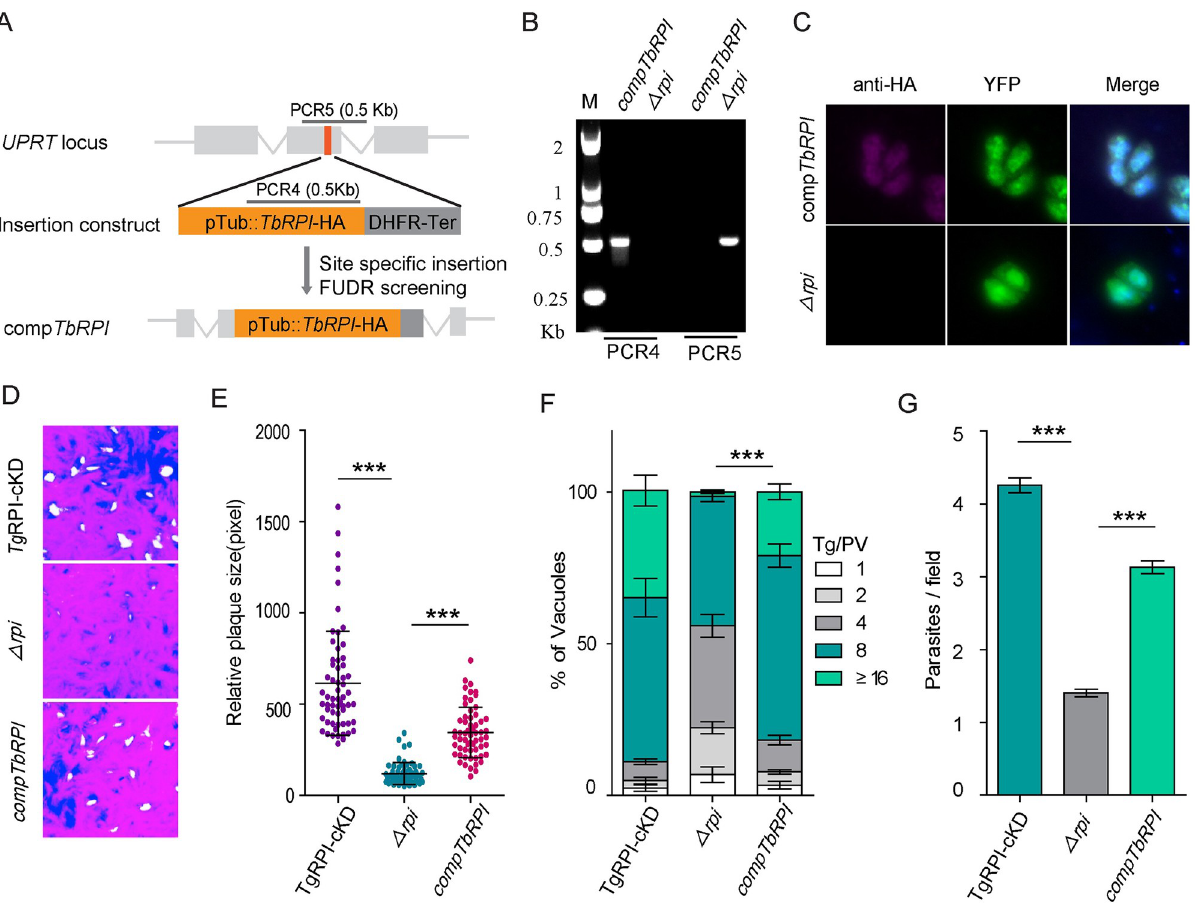
Fig 5. Trypanosoma brucei RPI complementation restored the growth defects of Tg RPI depletion mutants. (A) , Schematic diagram showing the insertion of a Trypanosoma brucei RPI expressing mini gene into the UPRT locus of the Δ rpi strain by CRISPR/Cas9 mediated site-specific integration and selection with 10 μ M FUDR. (B) , Diagnostic PCRs on a selected comp Tb RPI clone. PCR4 examined the successful insertion of Trypanosoma brucei RPI on the UPRT locus, whereas PCR5 confirmed the deletion of the endogenous UPRT locus. (C) , Expression of the complementing Trypanosoma brucei RPI as shown by IFA using rabbit anti-HA. (D - E) , Plaque assays comparing the growth of Tg RPI depletion strain before and after Trypanosoma brucei RPI complementation. Means ± SD of more than 60 plaques for each strain was graphed. Student’s t-test, ��� , P < 0 . 001 . (F) , Intracellular replication rates of depicted strains (24 h post-infection). Means ± SEM from three independent experiments (n = 3), each with two replicates. ��� , P < 0 . 001 by two-way ANOVA. (G) , The invasion efficiency of the comp Tb RPI was compared to the Tg RPI-cKD and Δ rpi parasites. Means ± SD of more than 100 fields from three independent assays, ��� , P < 0 . 001 ; one-way ANOVA.